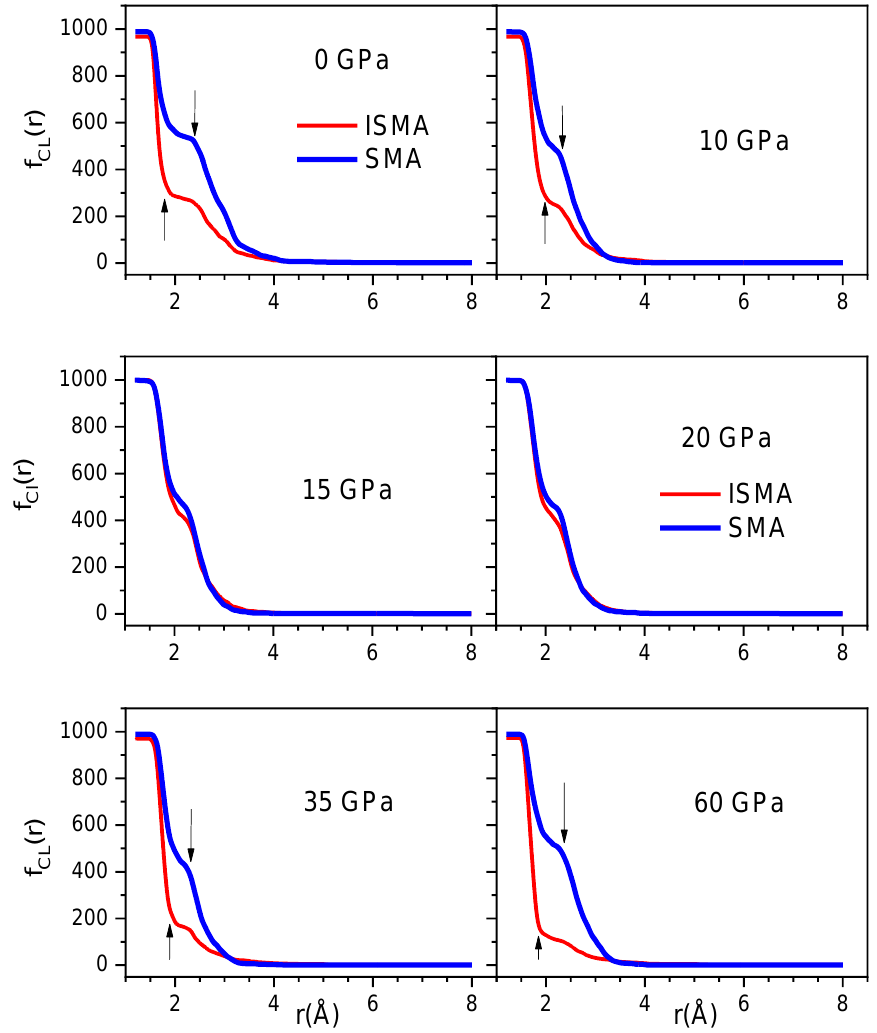
Figure 10. The CL-function for atoms of SMA and SIMA in the AS2 configurations at time t = 80 ps, at different pressures. Here, the black arrows denote the position that the curves drop the